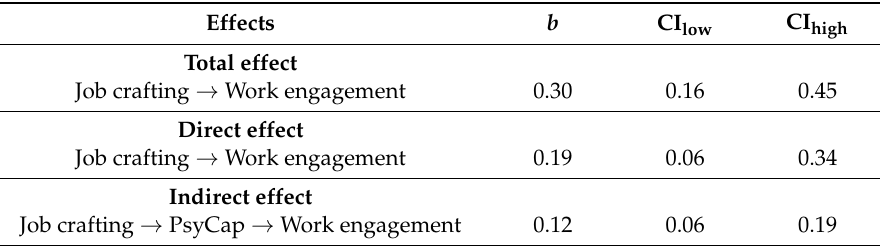
Table 3. Mediating effect of